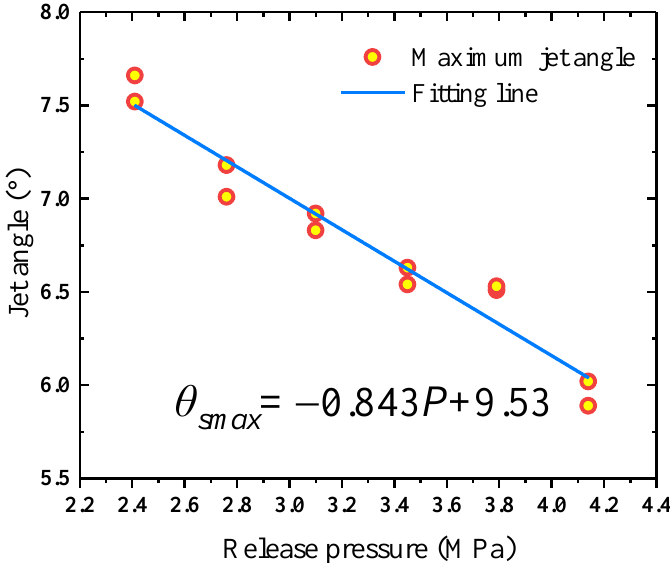
Figure 12. The maximum jet angle versus the release pressure.